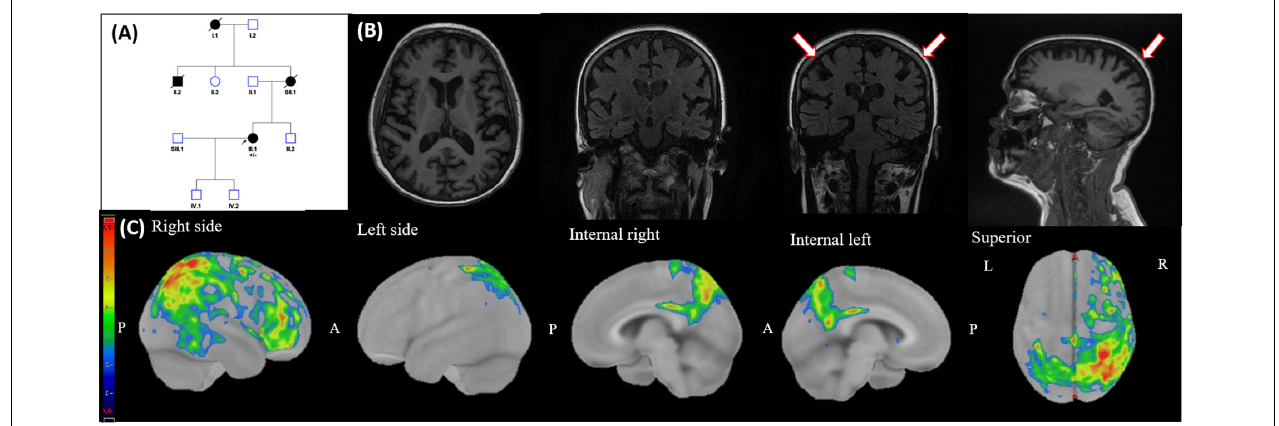
FIGURE 1 | Family 1: pedigree, brain MRI, and 18F-fludeoxyglucose PET (FDG-PET). (A) Family pedigree. Dark symbols represent affected individuals, mother of proband died at age 64 after being diagnosed with early-onset dementia. Her maternal uncle was mentally retarded, and the grandmother of proband suffered an unspecified neurodegenerative disease. Arrow points to the proband. (B) Brain MRI showing widespread moderated cortical atrophy, strikingly in parietal lobes and precuneus (red arrows), but preserving hippocampus. (C) FDG-PET of the brain shows diffuse cortical hypometabolism in the right hemisphere; and hypometabolism in the precuneus, posterior cingulate, and paracentral gyrus of the left hemisphere. Images represent z -score deviations (warmer colors, more hypometabolism). P, posterior; A, anterior; L, left; R, right.